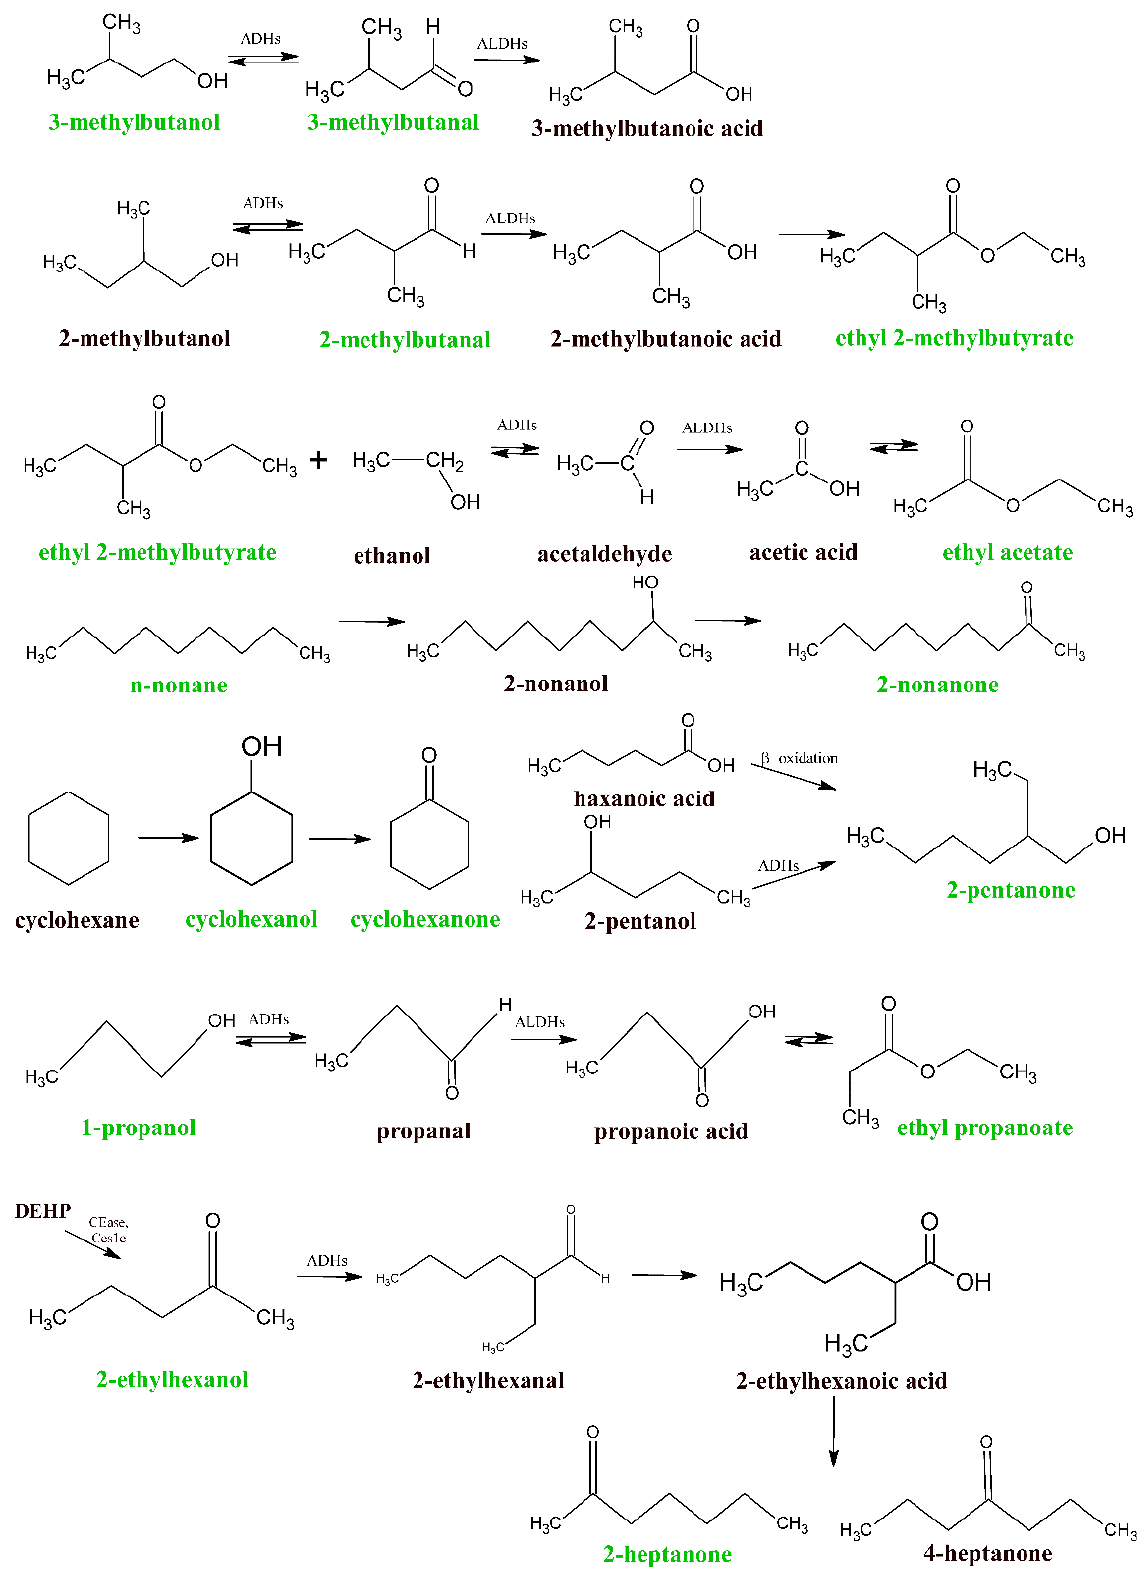
Figure 3. The proposed pathways leading to the consumption or production of some VOCs under study.